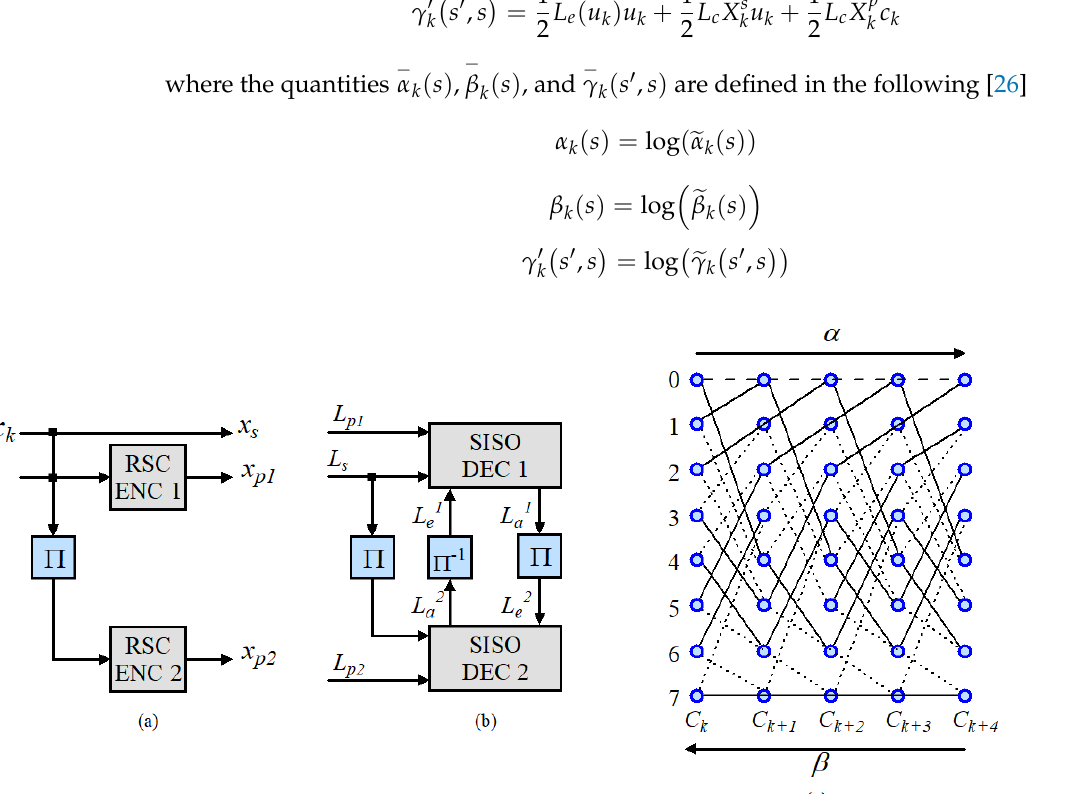
Figure 3. Block diagram of ( a ) turbo encoder, ( b ) decoder, and the ( c ) state transition diagram of turbo codes.